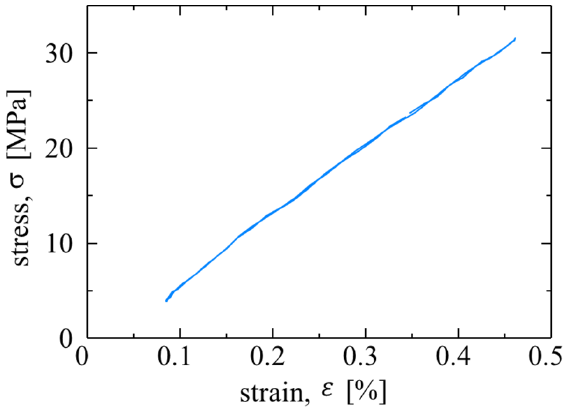
Figure 10. Hysteresis loop of strain and stress for vinyl ester specimen.